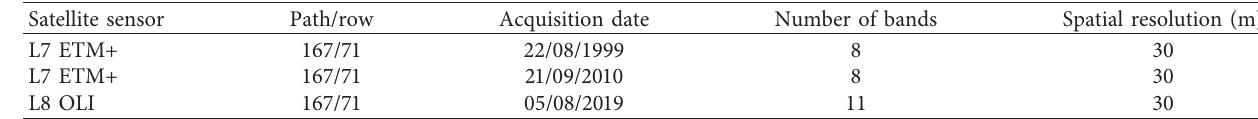
Table 1: Satellite imagery used.